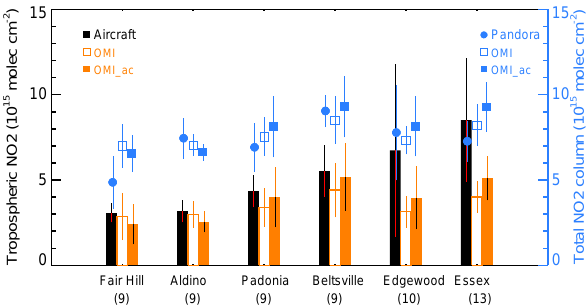
Figure 7. Comparison of average tropospheric (orange bars) and total (blue squares) NO 2 columns retrieved from OMI with tropo- spheric NO 2 columns determined from in situ aircraft (black bars) 20 measurements and total columns retrieved from Pandora (filled blue OMI tropospheric NO2 (10 15 molec cm -2 circles) at the six locations in Maryland during the DISCOVER-AQ field campaign. Open bars and squares represent the operational retrievals and filled bars and squares represent the retrievals per- formed using collocated aircraft-measured NO 2 vertical profiles. Figure 6. A summary plot showing comparison of collocated tropo- The vertical lines represent the standard deviation of the spheric (black) and total (orange) NO 2 columns derived from in situ aircraft measurements and retrieved from Pandora with OMI re- trievals performed using GMI NO 2 a priori vertical profiles (filled circles) and in situ NO 2 measurements (open circles). The dotted line represents the 1:1 relationship.